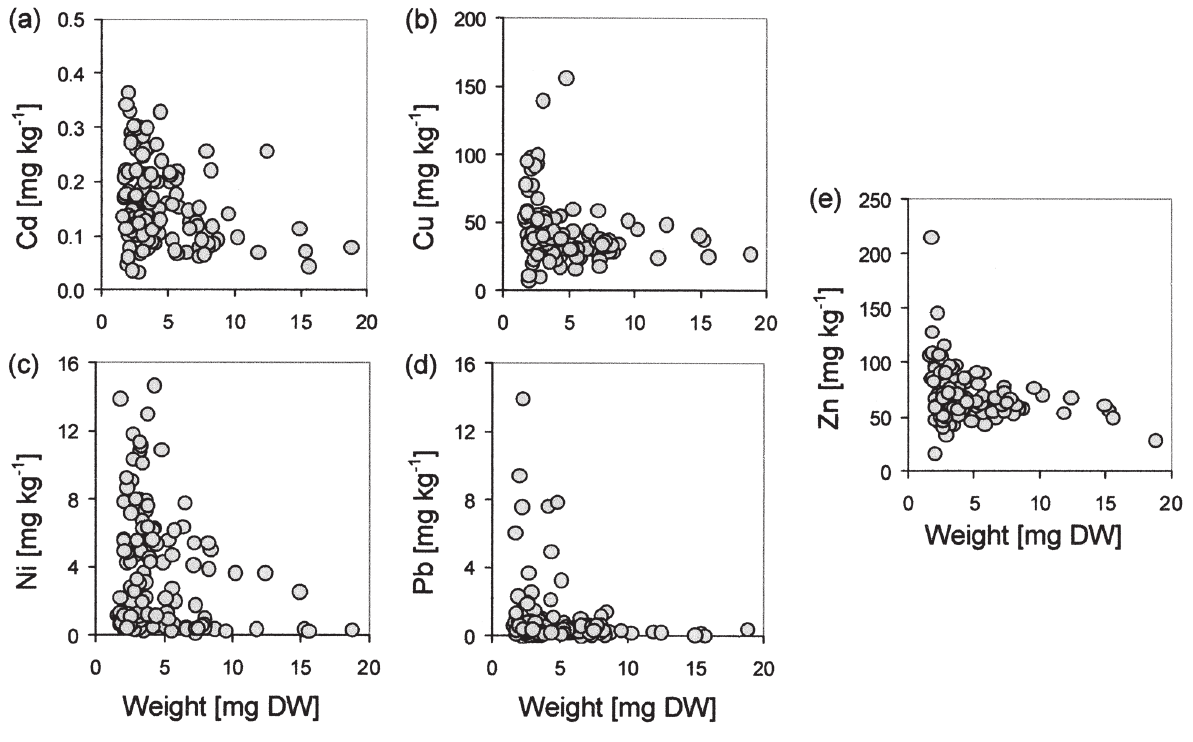
Fig . 5. – relationships between concentrations of (a) Cd , (b) Cu , (c) ni , (d) Pb and (e) Zn (mg kg -1 dW, respectively) and body dry weight (mg) for individually measured Crangon crangon sampled in July 2004 and 2005 in schillig, german Wadden sea Coast (Fig.